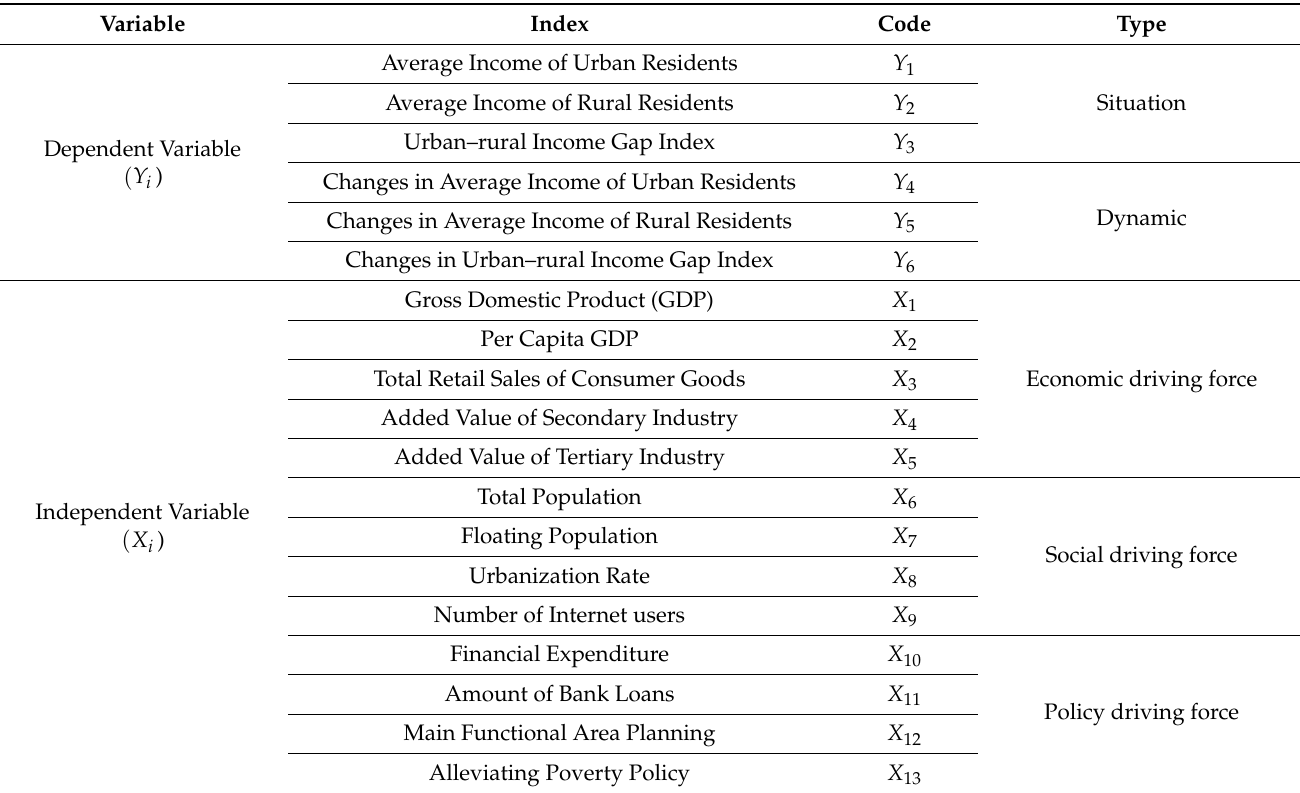
Table 2. Model variable